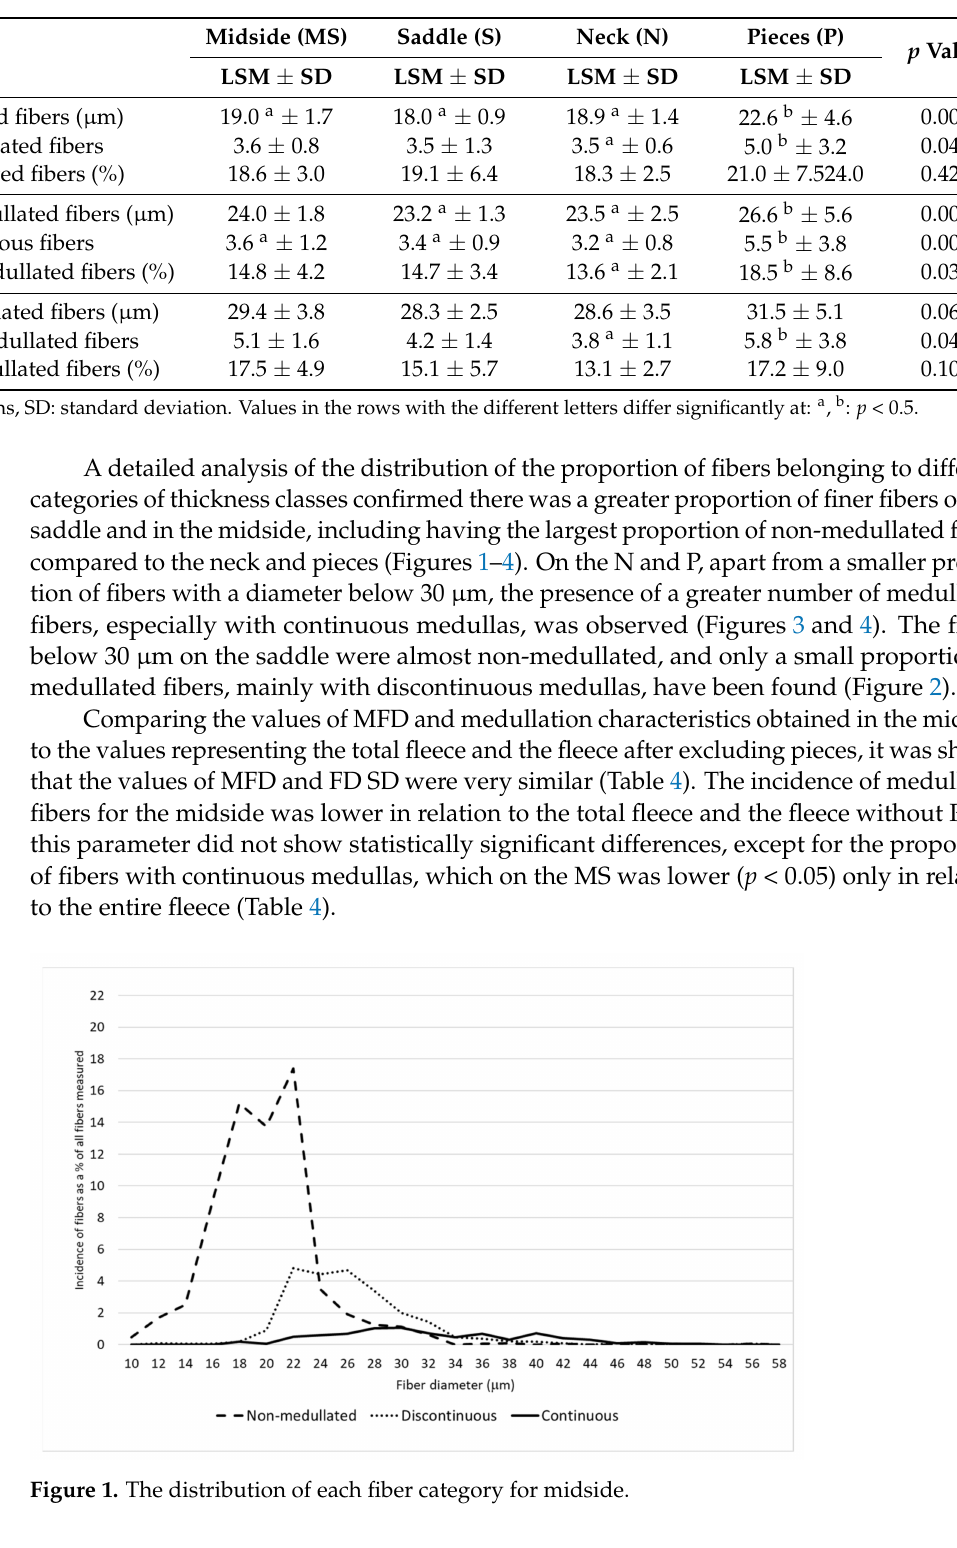
Table 3. Wool quality characteristics for each fiber category of different body sites.